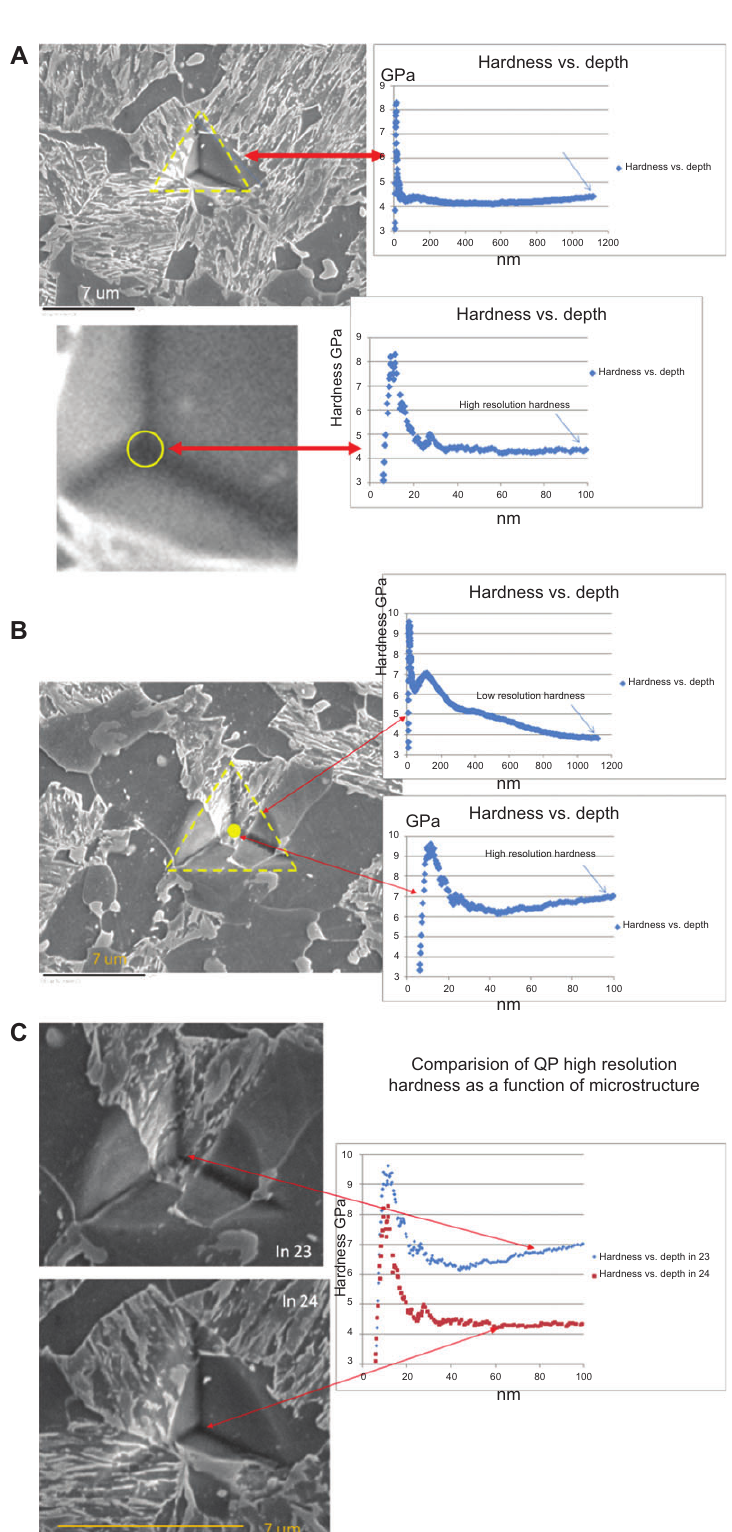
Figure 3 (A) Example of QP continuous hardness measurement increasing as the area fraction of strengthening phase under the indent increases as a function of indentation depth. (B) Example of QP continuous hardness measurement decreasing as the area fraction of strengthening phase under the indent decreases as a function of indentation depth. (C) Comparison of the QP high-resolution indentation continuous hardness measurement for the soft ferrite and relatively hard martensite/retained austenite microconstituents at the center of the